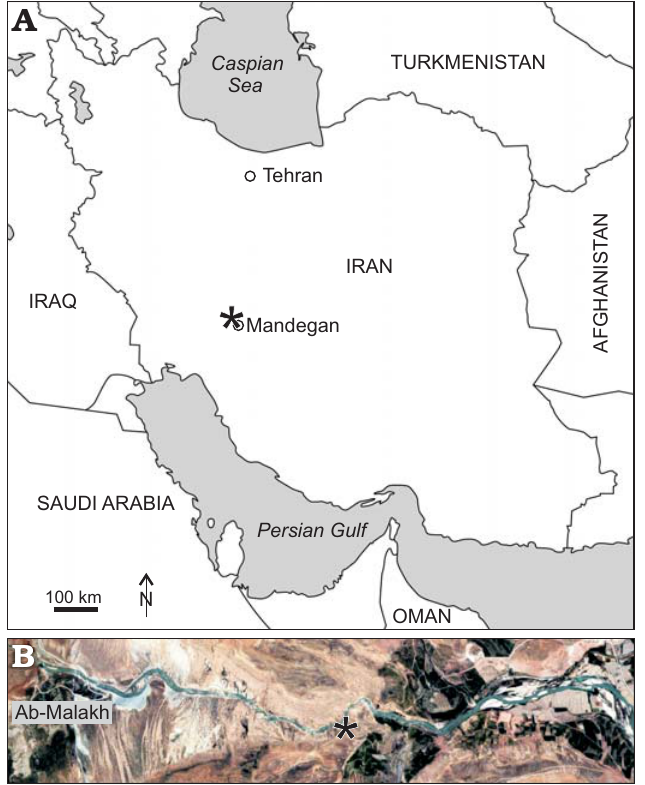
Fig. 2. Position (asterisked) of studied localities in the general map of Iran ( A ) and position of Rod-Abad section ( B ).